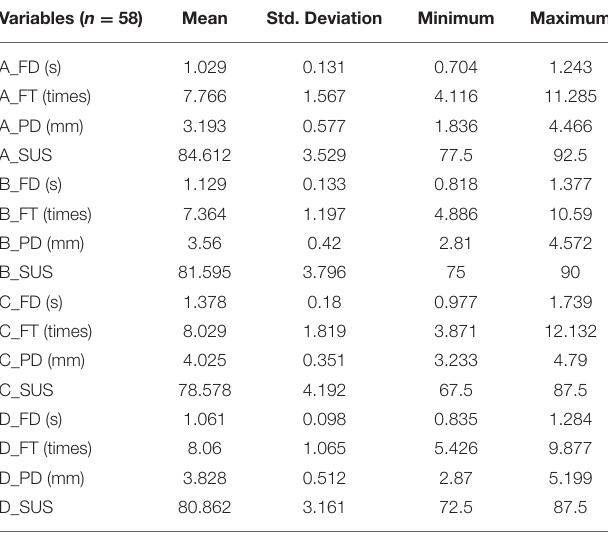
TABLE 5 | The eye movement characteristics and SUS scores under the four dashboard